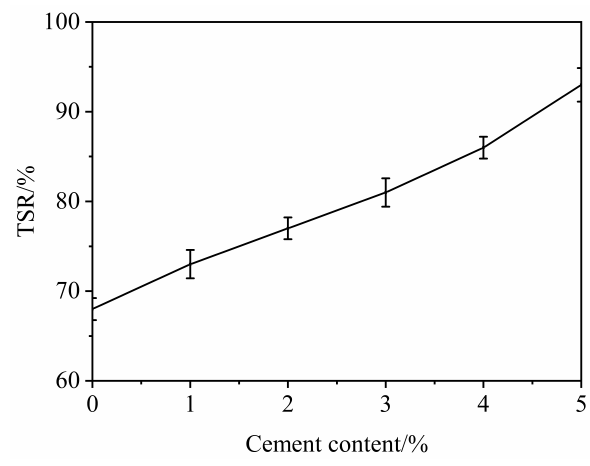
Figure 4. Results of moisture susceptibility test.